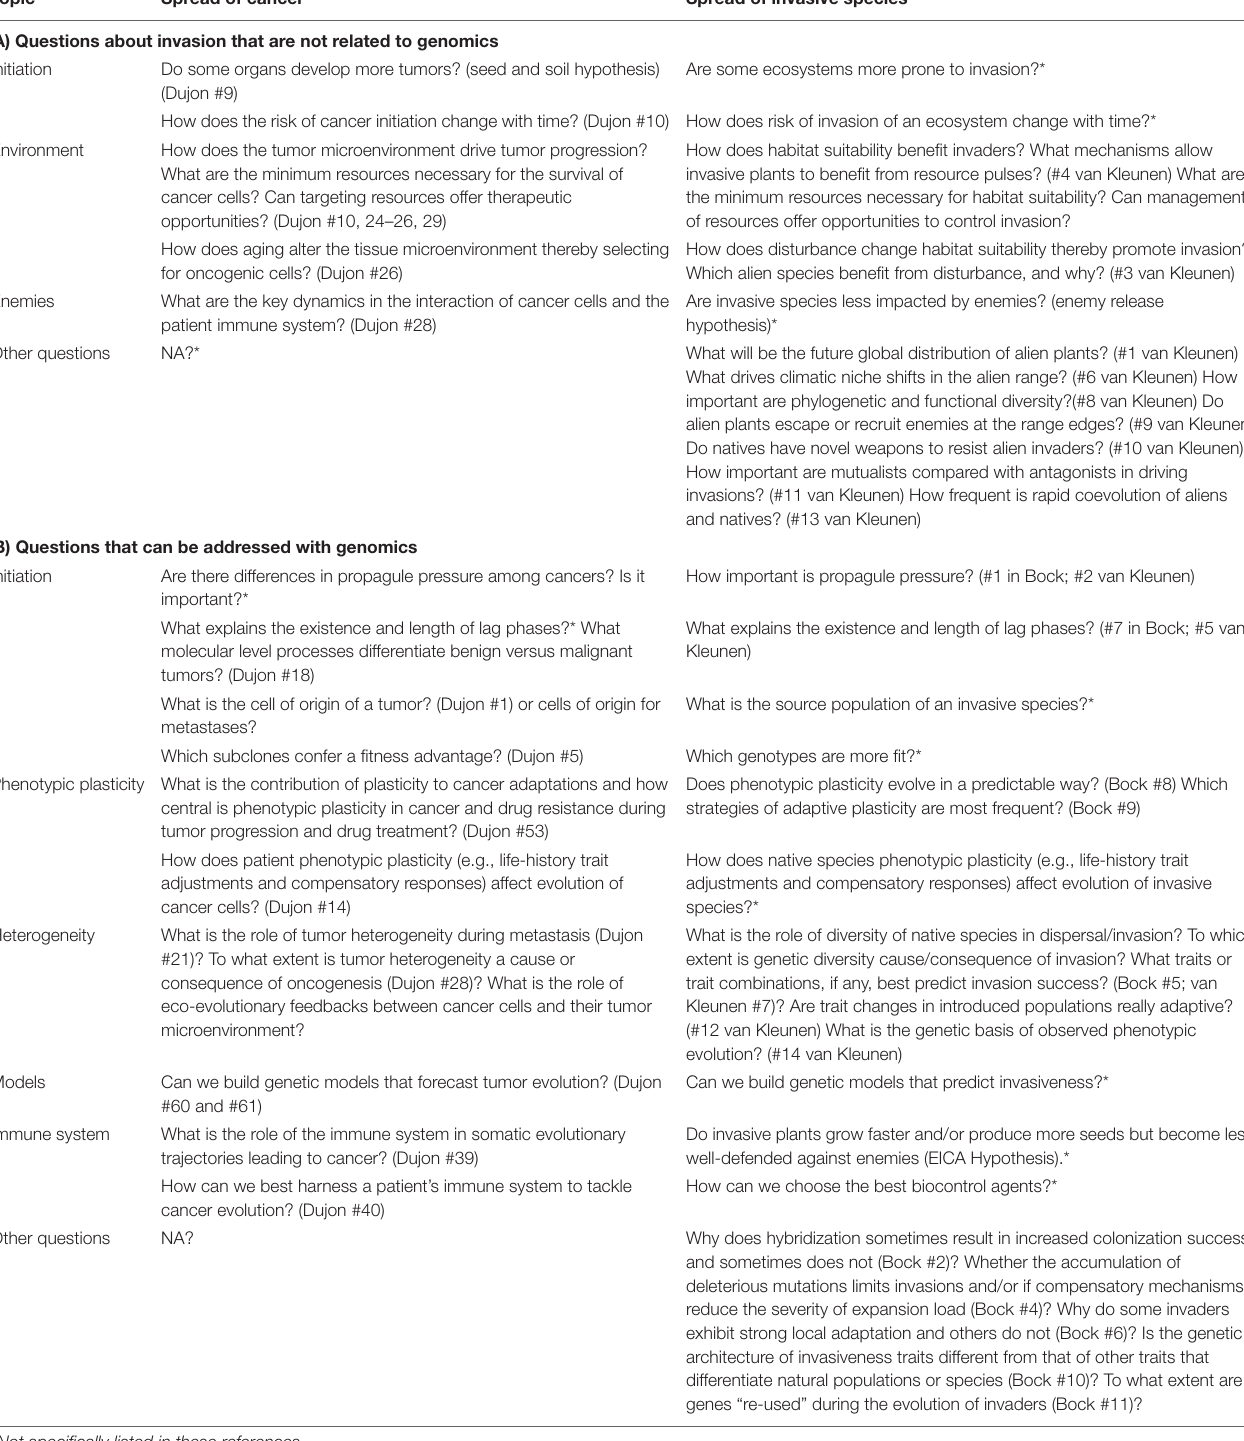
TABLE 2 | Similarities in approaches to study invasions in cancer and ecology [based on selected questions identified in Bock et al. (2015), van Kleunen et al. (2018), and Dujon et al. (2021)]. Topic Spread of cancer Spread of invasive